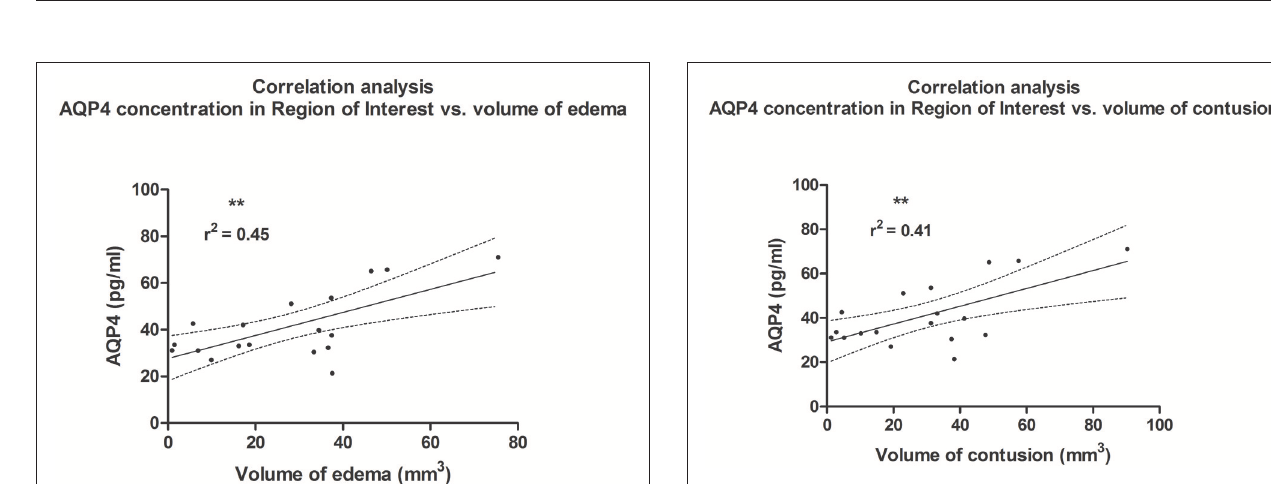
the size of contusional changes.